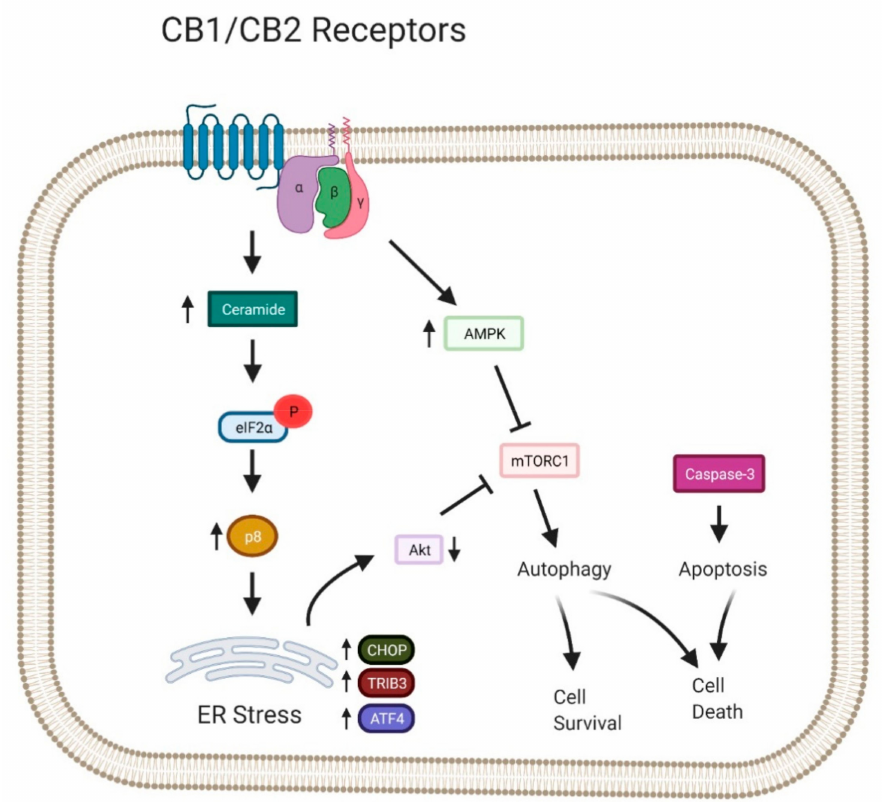
Figure 4. The Interplay between Autophagy and Apoptosis Induced by Cannabinoids [11]. eIF2a, Eukaryotic Initiation Factor 2 alpha; p8, stress-regulated protein p8; CHOP, CCAAT/enhancer- binding protein homologous protein; TRIB3, pseudokinase tribbles homologue-3; ATF4, Activating transcription factor 4; ER, endoplasmic